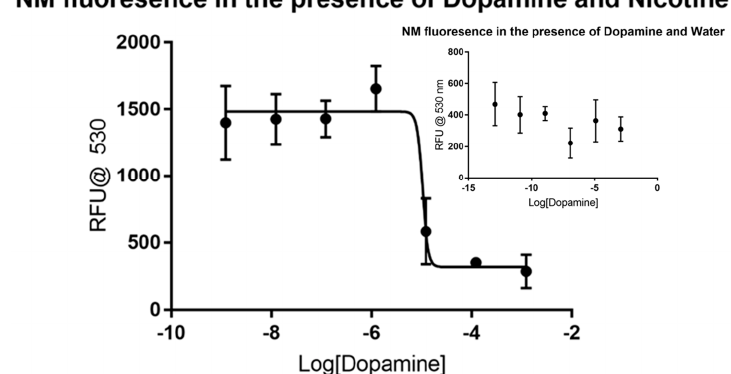
Figure 2. Fluorescence of synthetic neuromelanin upon exposure to dopamine in the absence (inset) and presence of nicotine as a signal molecule. Like the situation with MPP+ from Figure 1, dopamine does not itself appear to induce a stable fluor signal from NM-Fe in aqueous solution as judged by the high variability and low average RFU counts of quadruplicate measurements (inset). On the addition of nicotine, an enhanced signal appears to stabilize slightly with a sharp inflection evident near 10 − 5 M dopamine, in agreement with our prior published estimate of an 0.05 mM K d [23].